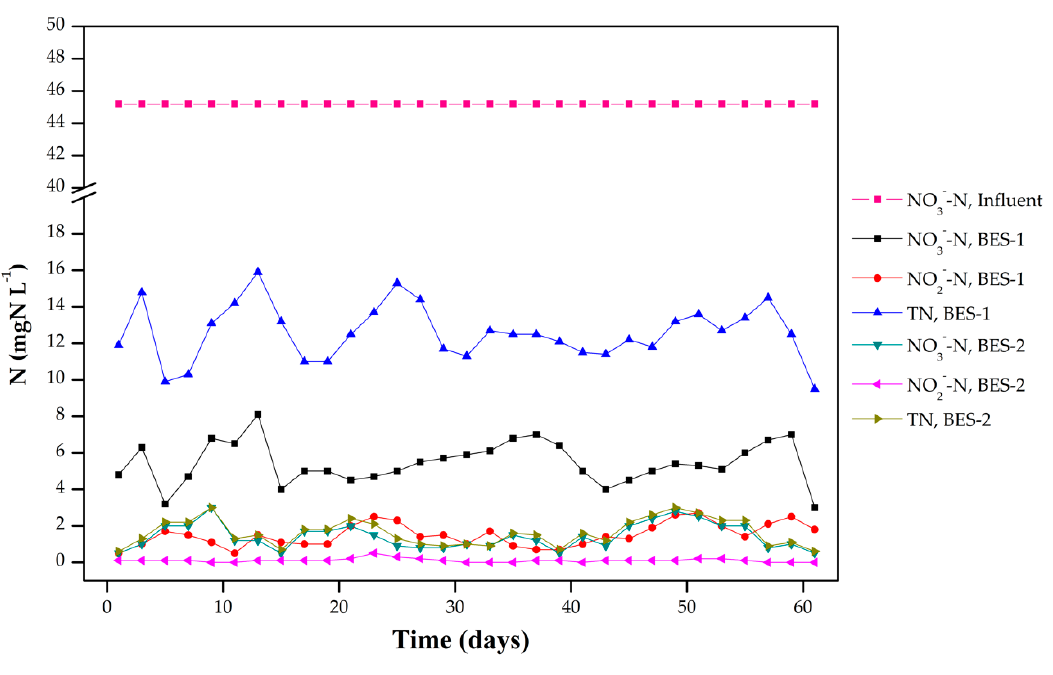
Figure 2. Nitrogen forms in the effluent of BES-1 and BES-2 during the experimentation. The effluent of BES-2 is also the effluent of the sequential system.